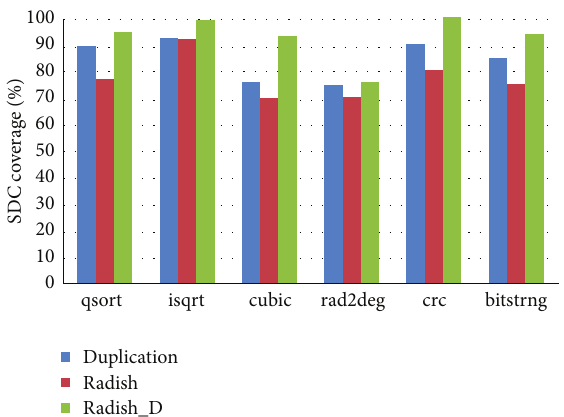
Figure 5: The comparison of SDC coverages among full instruction duplication, Radish, and Radish D.